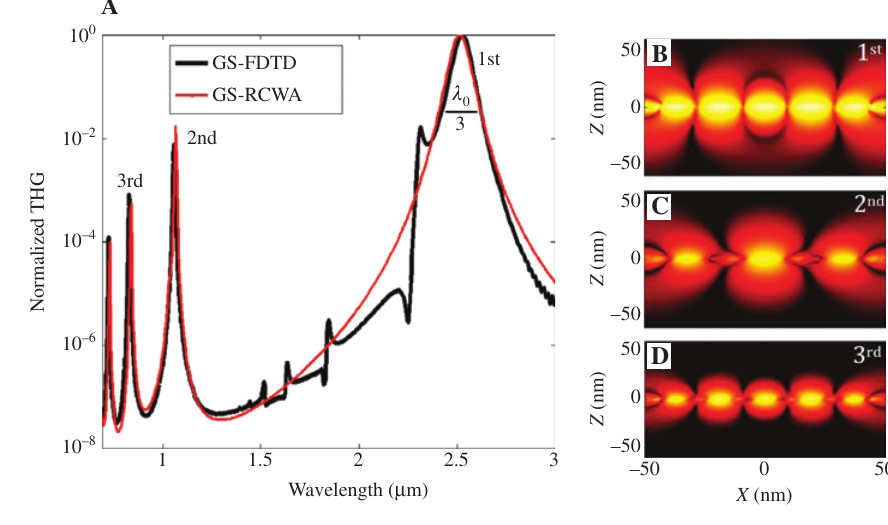
Figure 5: Nonlinear results at TH. (A) comparison of THG calculated by different methods and (B–D) field profile of | E